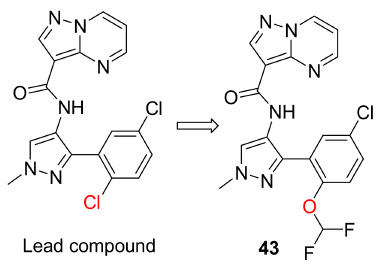
Figure 50. Schematic view the development of 43 .